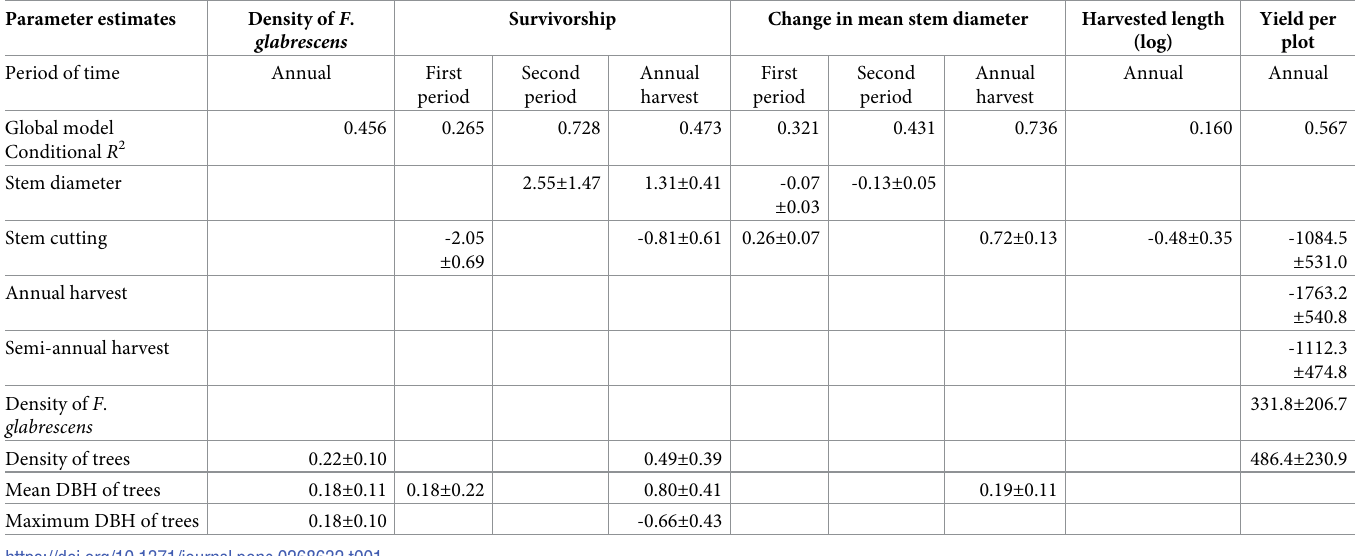
Table 1. Fit and summary of estimates (multi-model averaging) of effects ( ± standard errors) of Forsteronia glabrescens attributes and forest stand factors on popu- lation parameters and harvest yield.